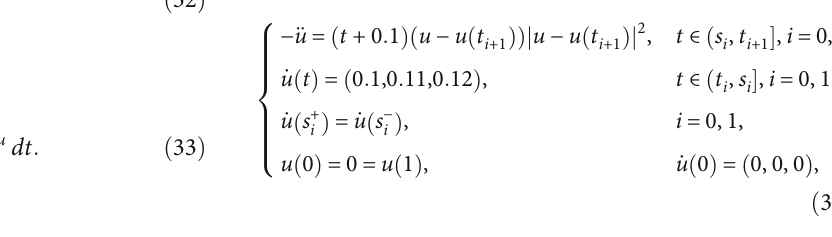
ffiffiffiffiffiffiffiffiffiffiffiffiffiffiffiffiffiffiffiffiffiffiffiffiffiffi p 2 ð 1 + ð 1/ π 2 ÞÞ